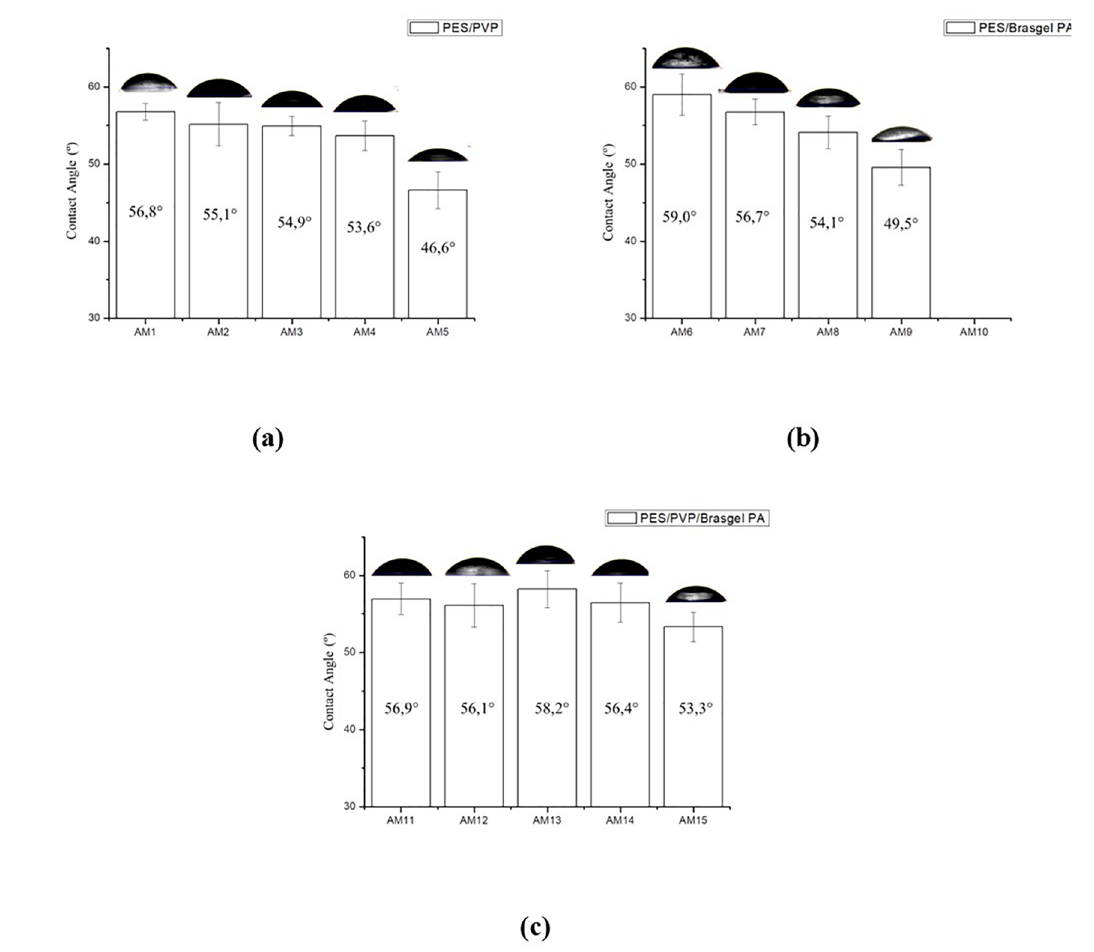
Figure 2. Contact angles with distilled water for the membranes with: (a) PVP, (b) Clay Brasgel PA and (c) PVP + Brasgel PA. Both additives had similar behavior, where the higher the concentration of PVP-9% and Brasgel PA-7%, the lower the angle (46.6º and 49.5º, respectively), i.e., the greater the